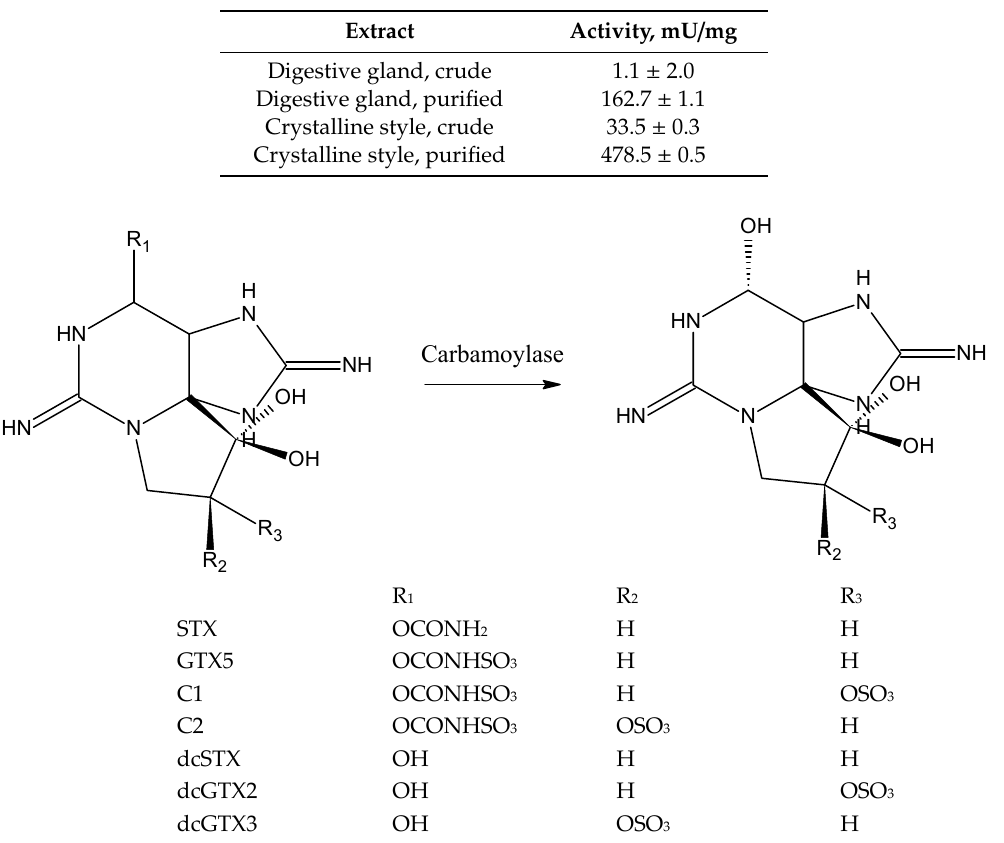
Table 1. Enzymatic activity towards STX of carbamoylase present in crude and purified extracts of surf clam digestive gland and crystalline style after 3 h of incubation.